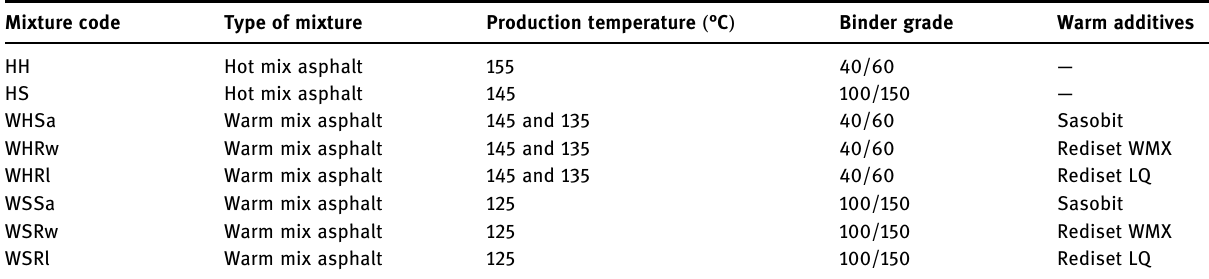
Table 4: Code de fi nitions of HMAs and WMAs Mixture